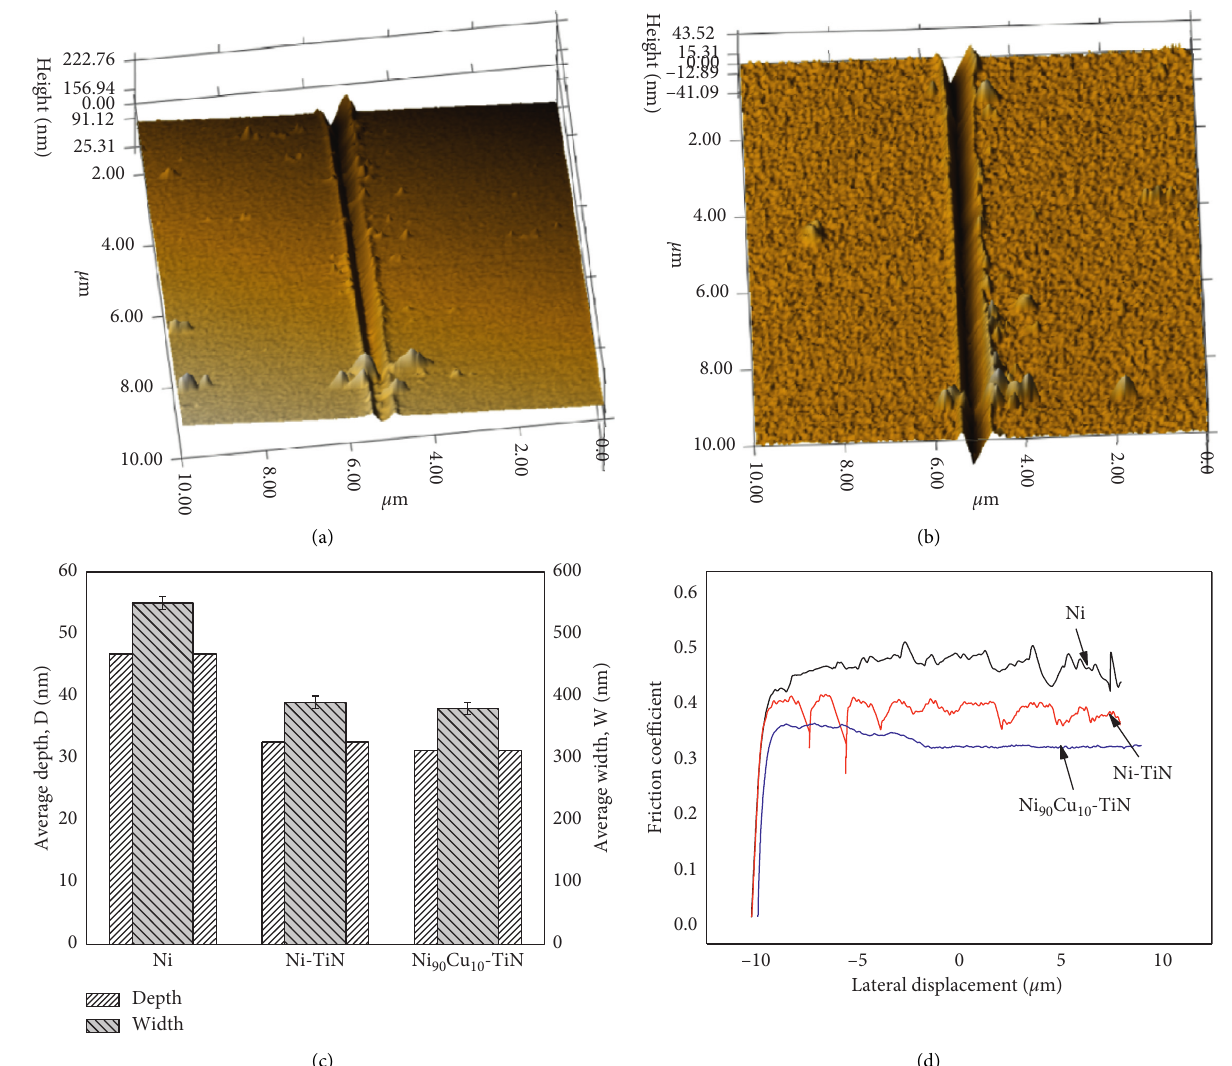
Figure 5: (a, b) Surface profile of scratch of Ni-TiN and Ni of COF with lateral